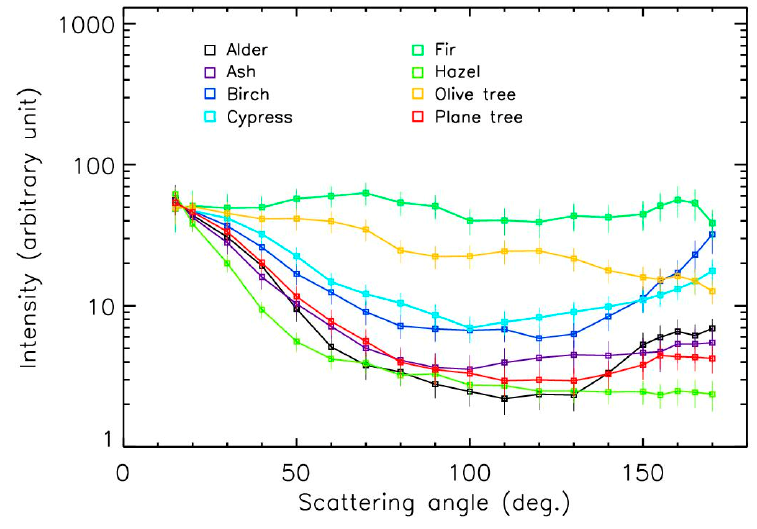
Figure 9. Intensity curves in the red domain for tree pollens.